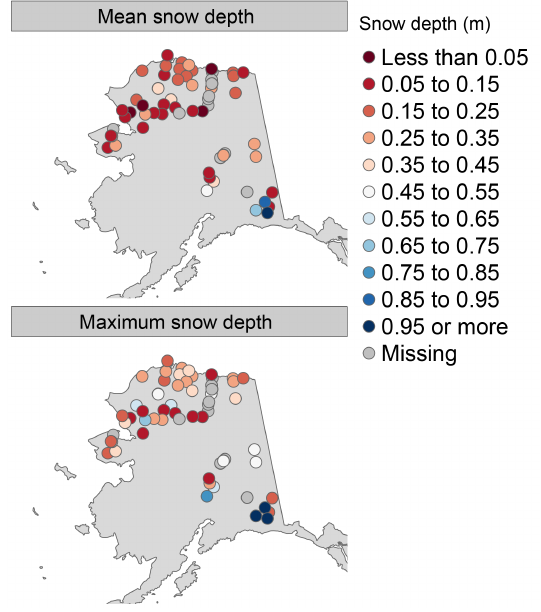
Figure 5. Overview of spatial distribution of snow depth, including annual mean snow depth and maximum snow